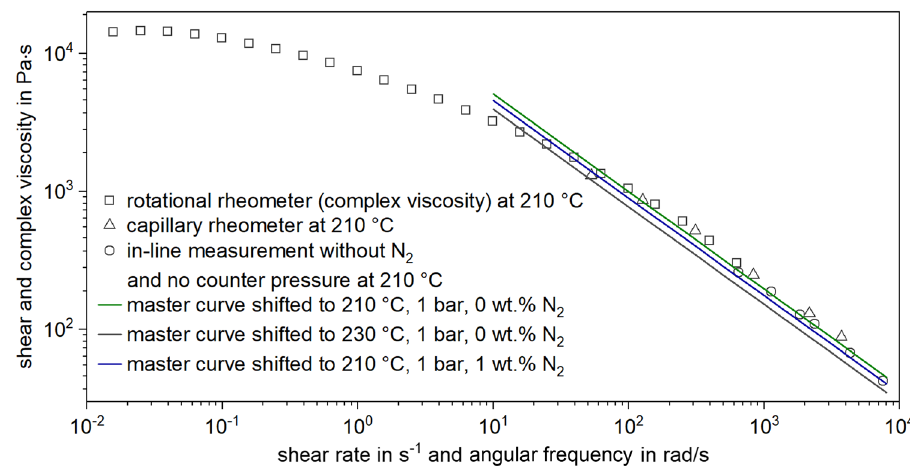
Figure 11: Validation of in - line viscosity measurements and superposition principles for PLA +